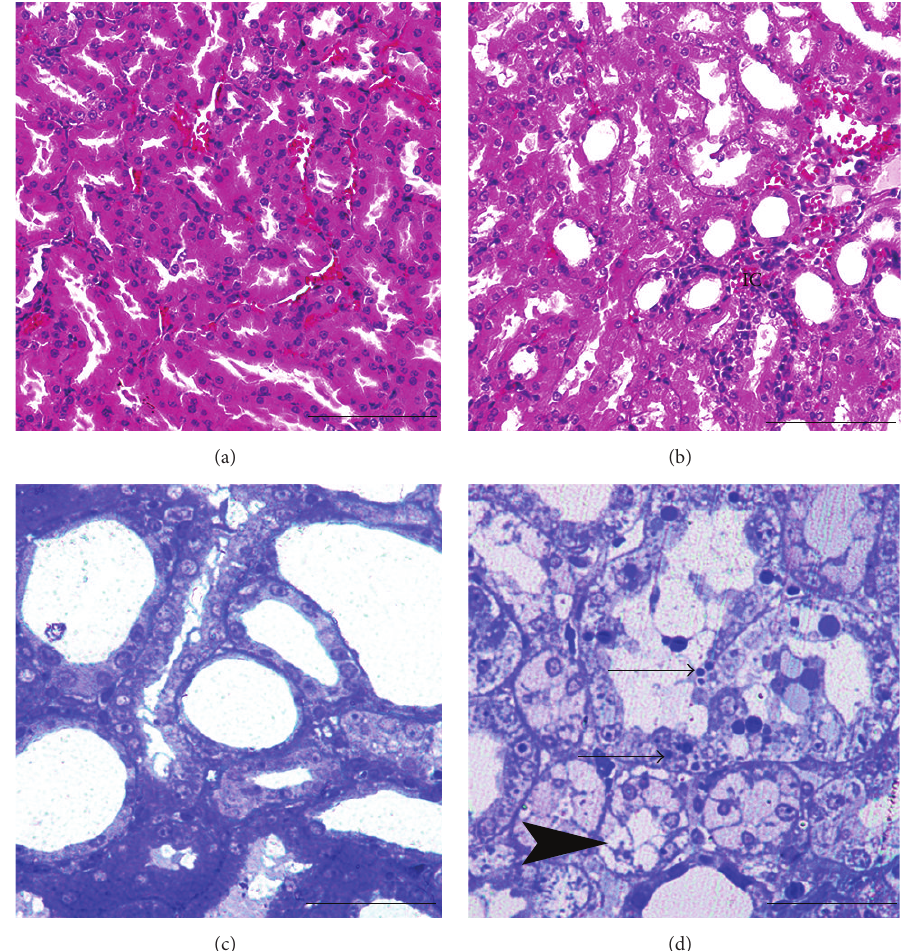
Figure 3: Morphology of renal tubular cells of HRs ((a), (c)) and CIN + DRs ((b), (d)). Histopathological changes such as mononuclear and polymorphonuclear leukocytes infiltration of interstitial cells (IC) of CIN + DRs (Figure 3(b)). Apoptotic tubular cells with membrane-bound apoptotic bodies (black arrow) and quite noticeable glucogenic vacuolization (arrow head) in tubular cells of CIN + DRs (Figure 3(d)). Note: histological micrographs were stained with H&E and had scale bars with 500 𝜇 (Figures 3(a) and 3(b)). Histological micrographs were stained with toluidine blue and had scale bars with 150 𝜇 (Figures 3(c) and 3(d)). HRs: healthy rats; CIN + DRs: diabetic rats with contrast-induced